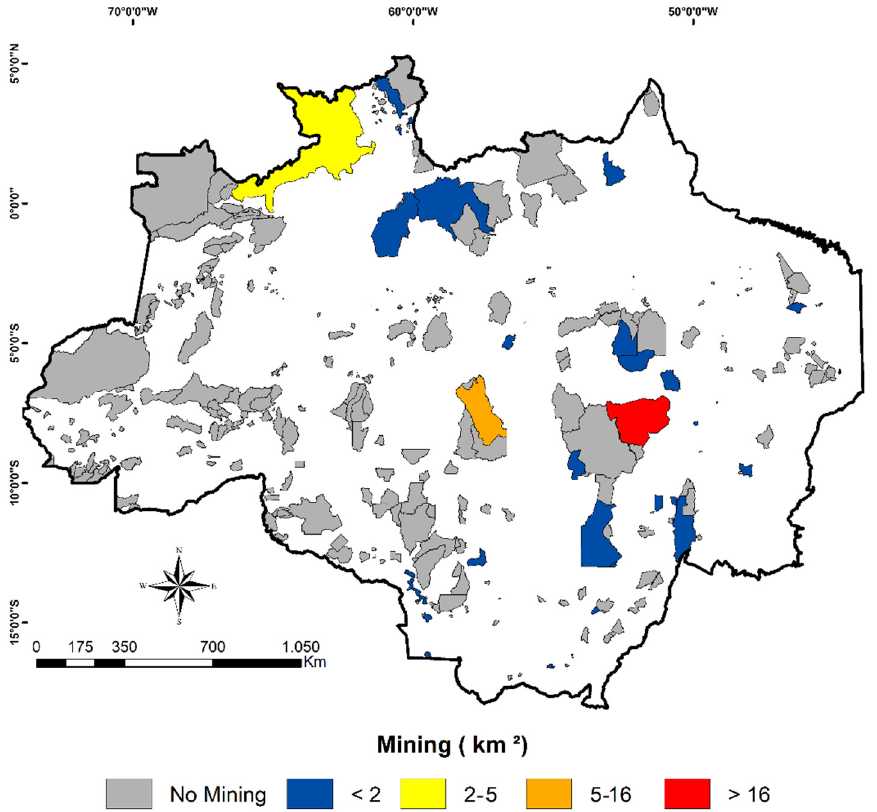
Figure 5. Spatial distribution of the areas classified as mining by the MapBiomas LULC dataset in 2020 within Indigenous Lands of the Brazilian Legal Amazon.